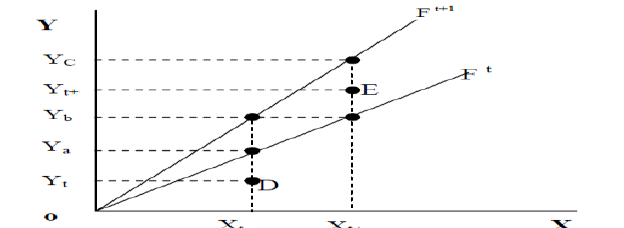
Figure 1. The Malmquist index and its components (Hakimipour and Avazalipour,